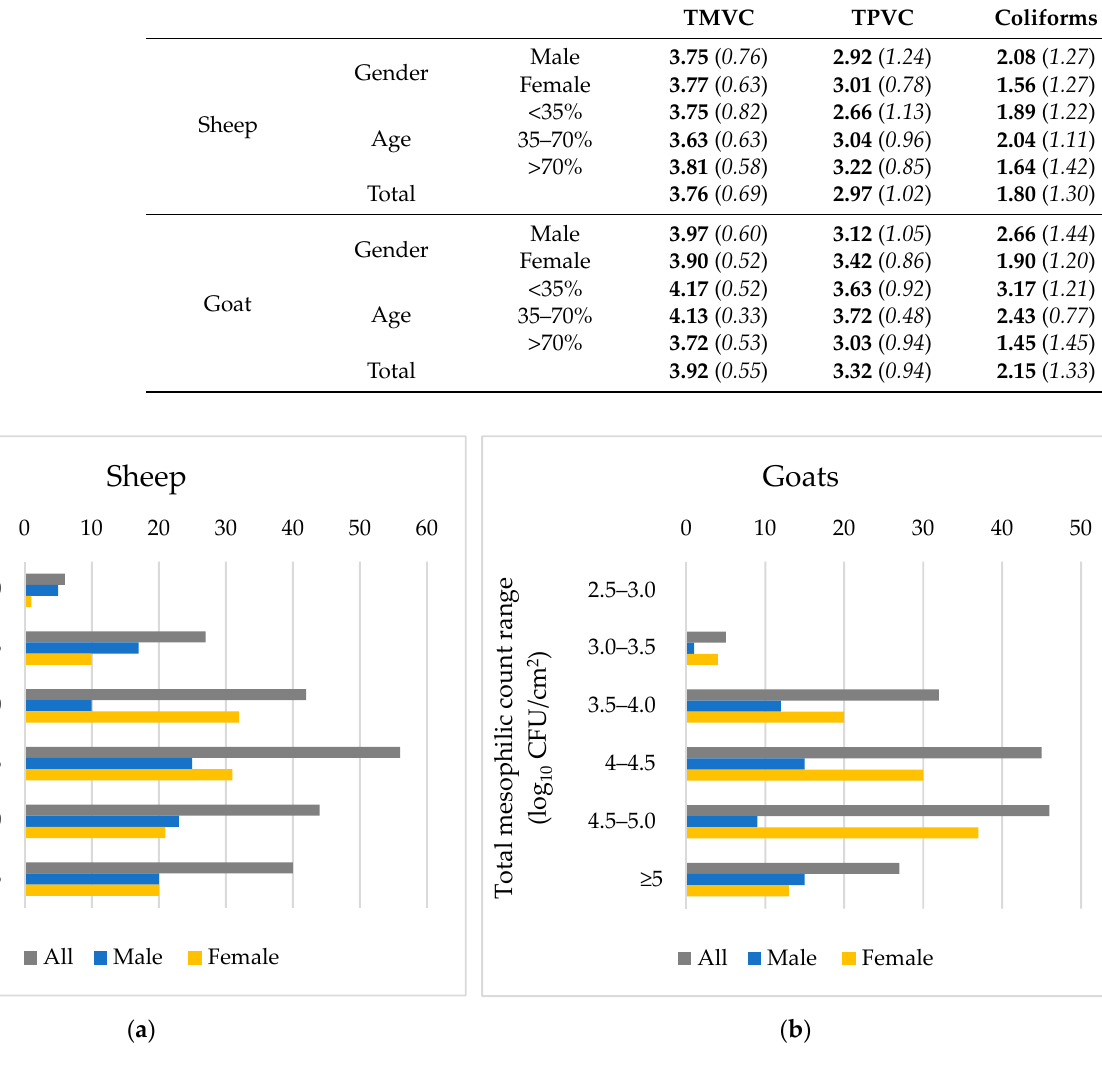
Figure 1. Number of sheep ( a ) and goat ( b ) carcasses categorized according to total mesophilic count (log 10 CFU/cm 2 ) range. Table 3. Microbial counts of sheep and goat carcasses (in log 10 CFU/cm 2 ), based on gender and age (average in bold, standard deviation in parentheses and italics).